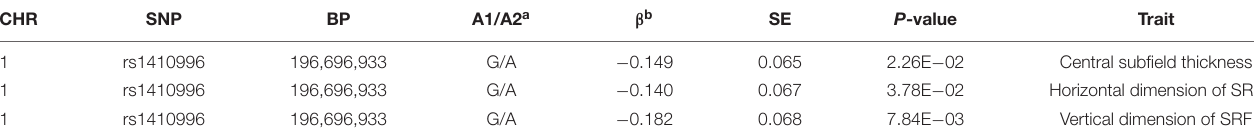
TABLE 4 | Association of rs1410996 with OCT manifestation.